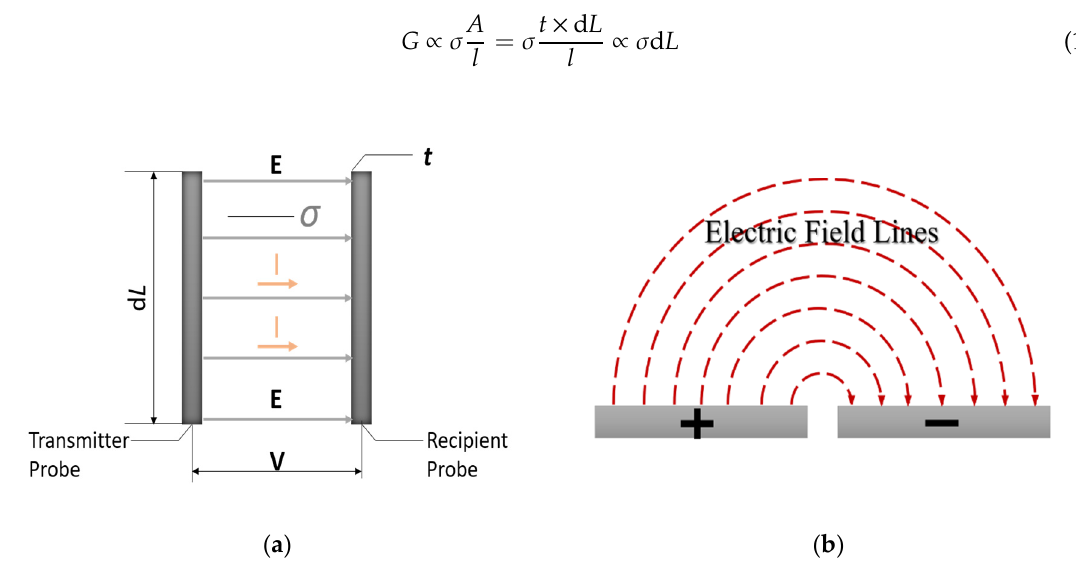
Figure 2. ( a ) Generic section of a typical configuration of pairs of probes. ( b ) Operating principle evolution from parallel capacitor to flat capacitor.